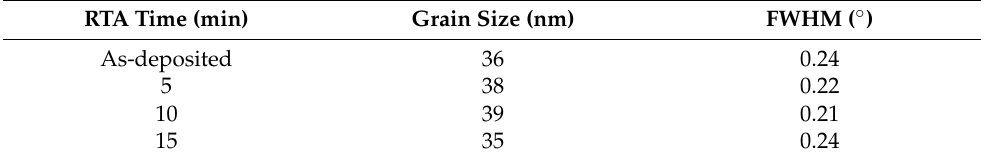
Table 4. Grain sizes and FWHMs of the ZnO thin films annealed at various temperatures for 10 min. RTA Temperature ( ◦ C) Grain Size (nm) FWHM ( ◦ ) As-deposited 36 0.24 300 36 0.24 400 39 0.21 500 41 0.20 Table 5. Grain sizes and FWHMs of the ZnO thin films annealed at 400 ◦ C with various times. RTA Time (min) Grain Size (nm) FWHM ( ◦ ) As-deposited 36 0.24 5 38 0.22 10 39 0.21 15 35